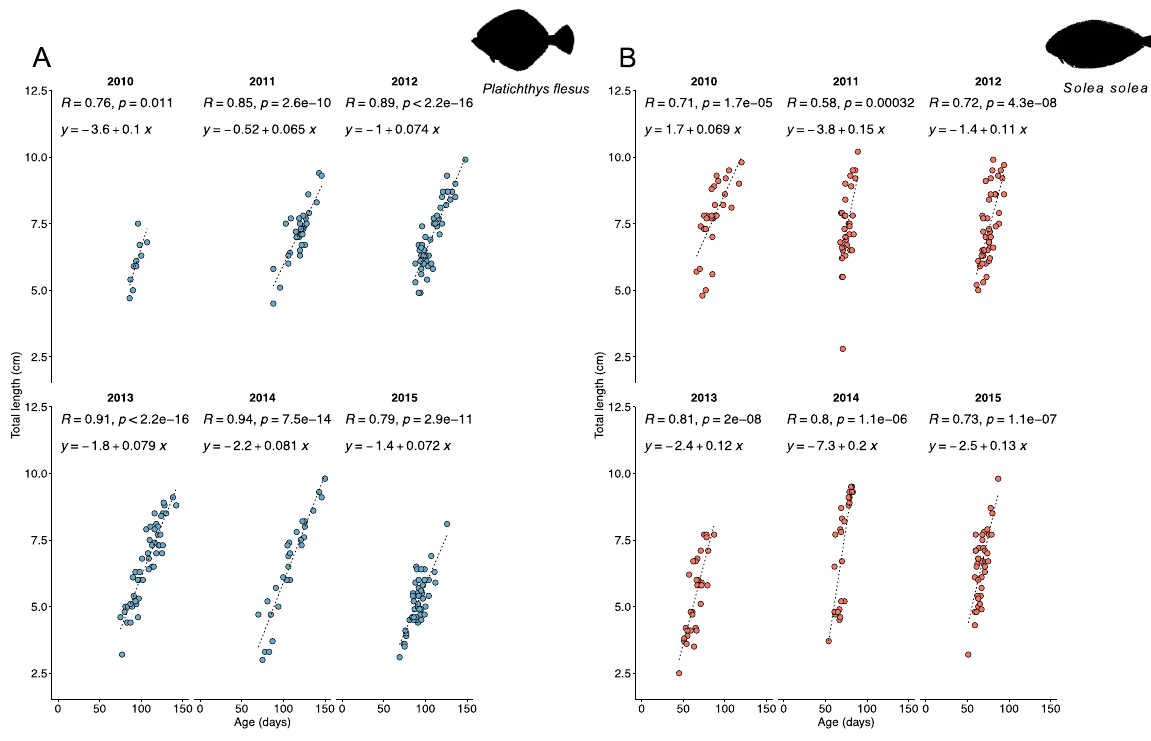
Figure 4. Linear regression between total length (cm) and age (days) for 0-group juvenile P. flesus ( A ) and S. solea ( B ) between 2010 and